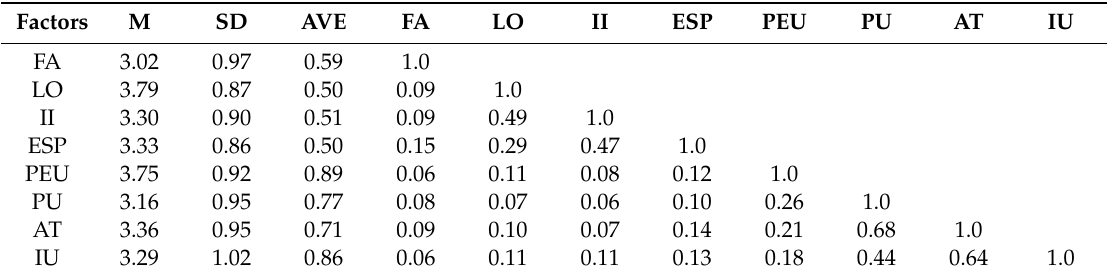
Table 2. Mean, standard deviation, convergent and discriminant validity.